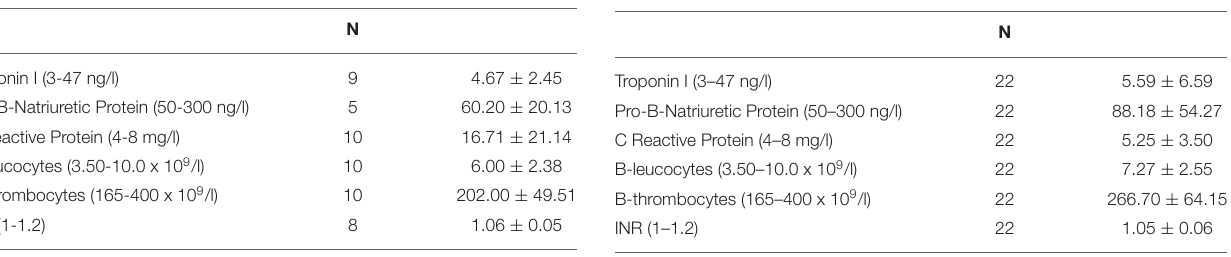
TABLE 3 | Table showing the results for blood serology at the time of investigation for long-term cardio-pulmonary symptoms. Brackets contain normal